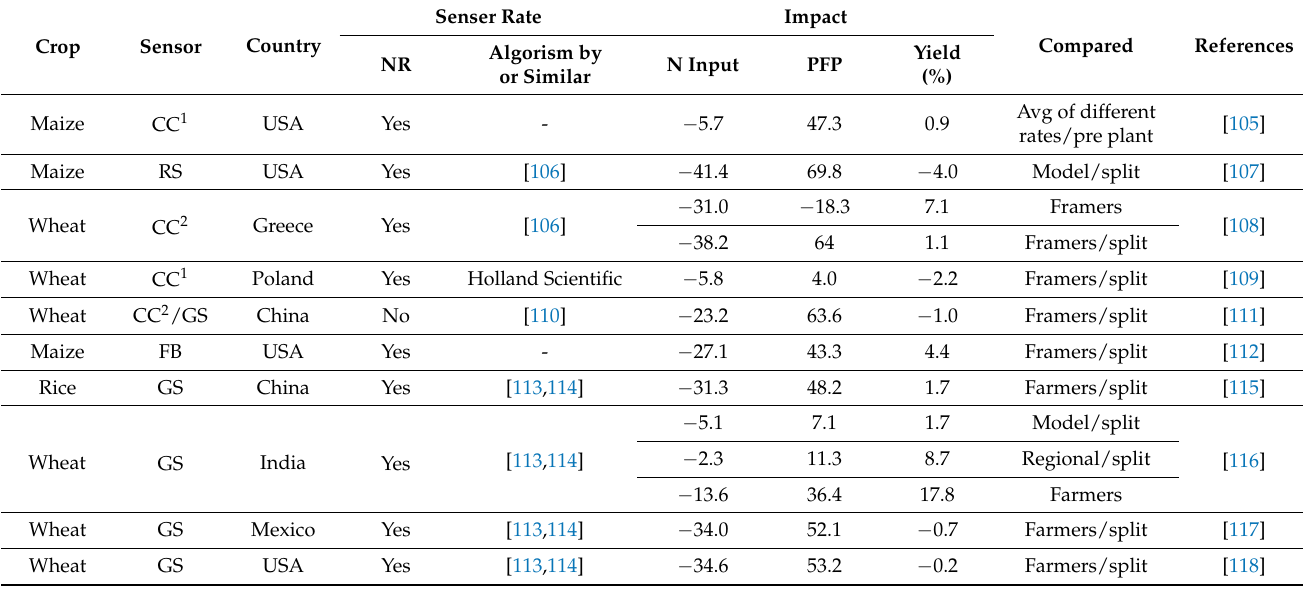
Table 3. Studies comparing sensor-based approaches with other N-management strategies (modified from Colaço and Bramley,